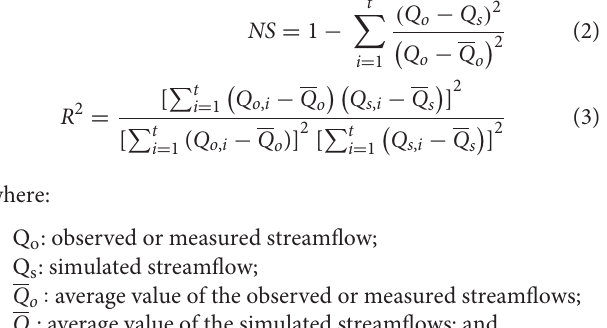
X P2 : cumulative distribution percentage of the simulated points corresponding to 97.5%; and σ x : standard deviation of measured quantity